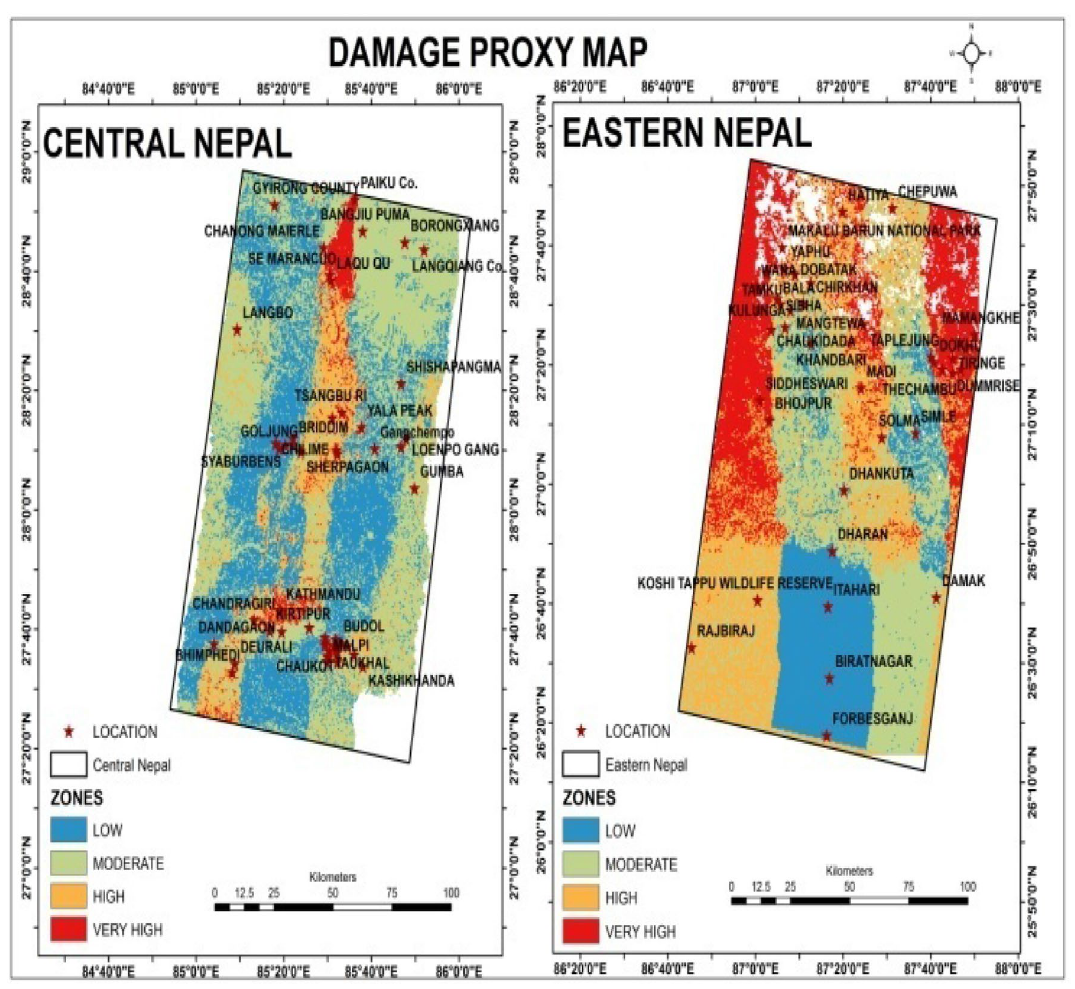
Fig. 10 Damage Proxy map of Central and Eastern Nepal